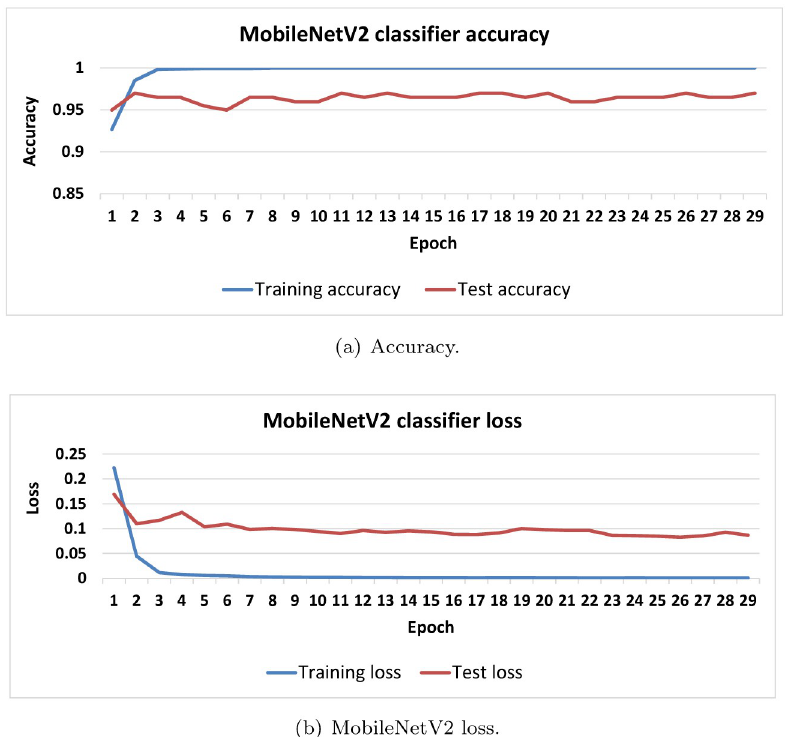
Fig 8. Evaluation metrics of tuned MobileNetV2 architecture (a) Training and test accuracy (b) Training and test loss.